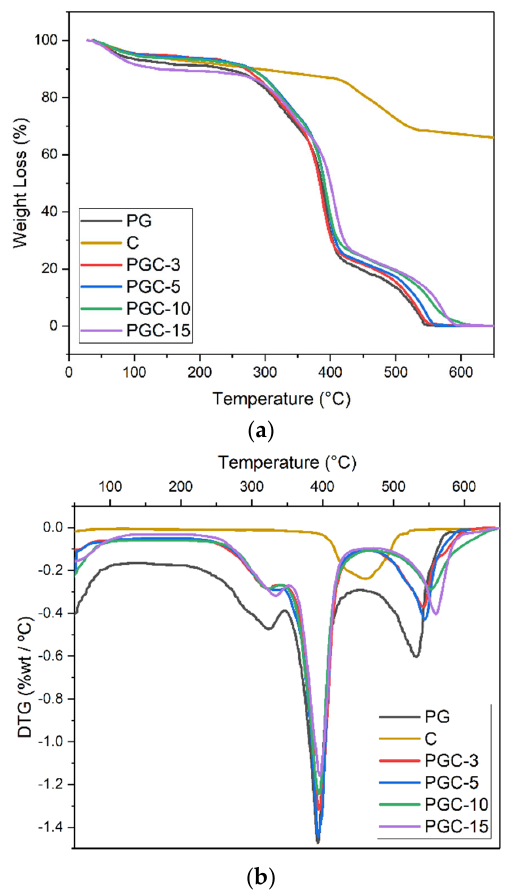
Figure 6. Weight loss of PG and PGC nanofibers ( a ) TGA, ( b ) DT. Table 1. TGA results of PG, SCX4, and PGC.